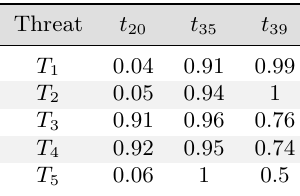
during stages t and 1 , . . . , T 5 20 , t 35